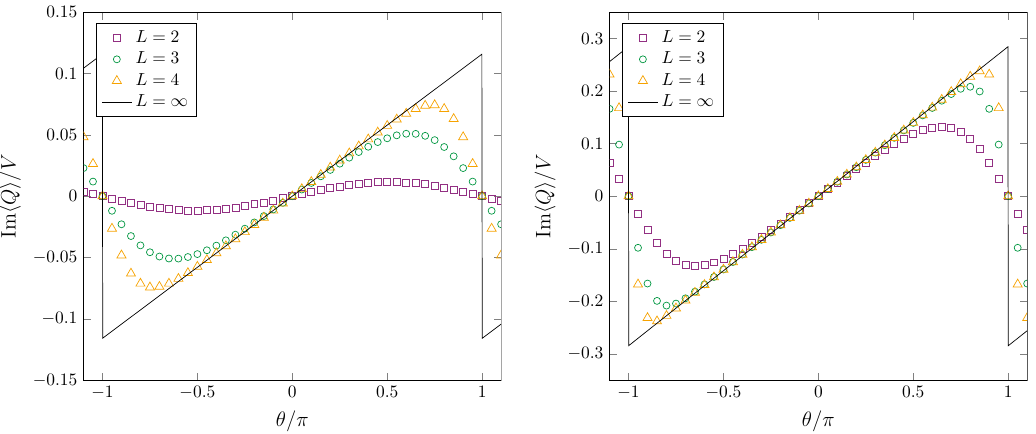
Figure 15 . The imaginary part of the topological charge density is plotted against θ for the U( 3 ) gauge theory with various L , D cut = 32 using λ = 1 . 5 (Left) and λ = 3 (Right). A clear gap is seen to develop at θ = ± π with increasing L